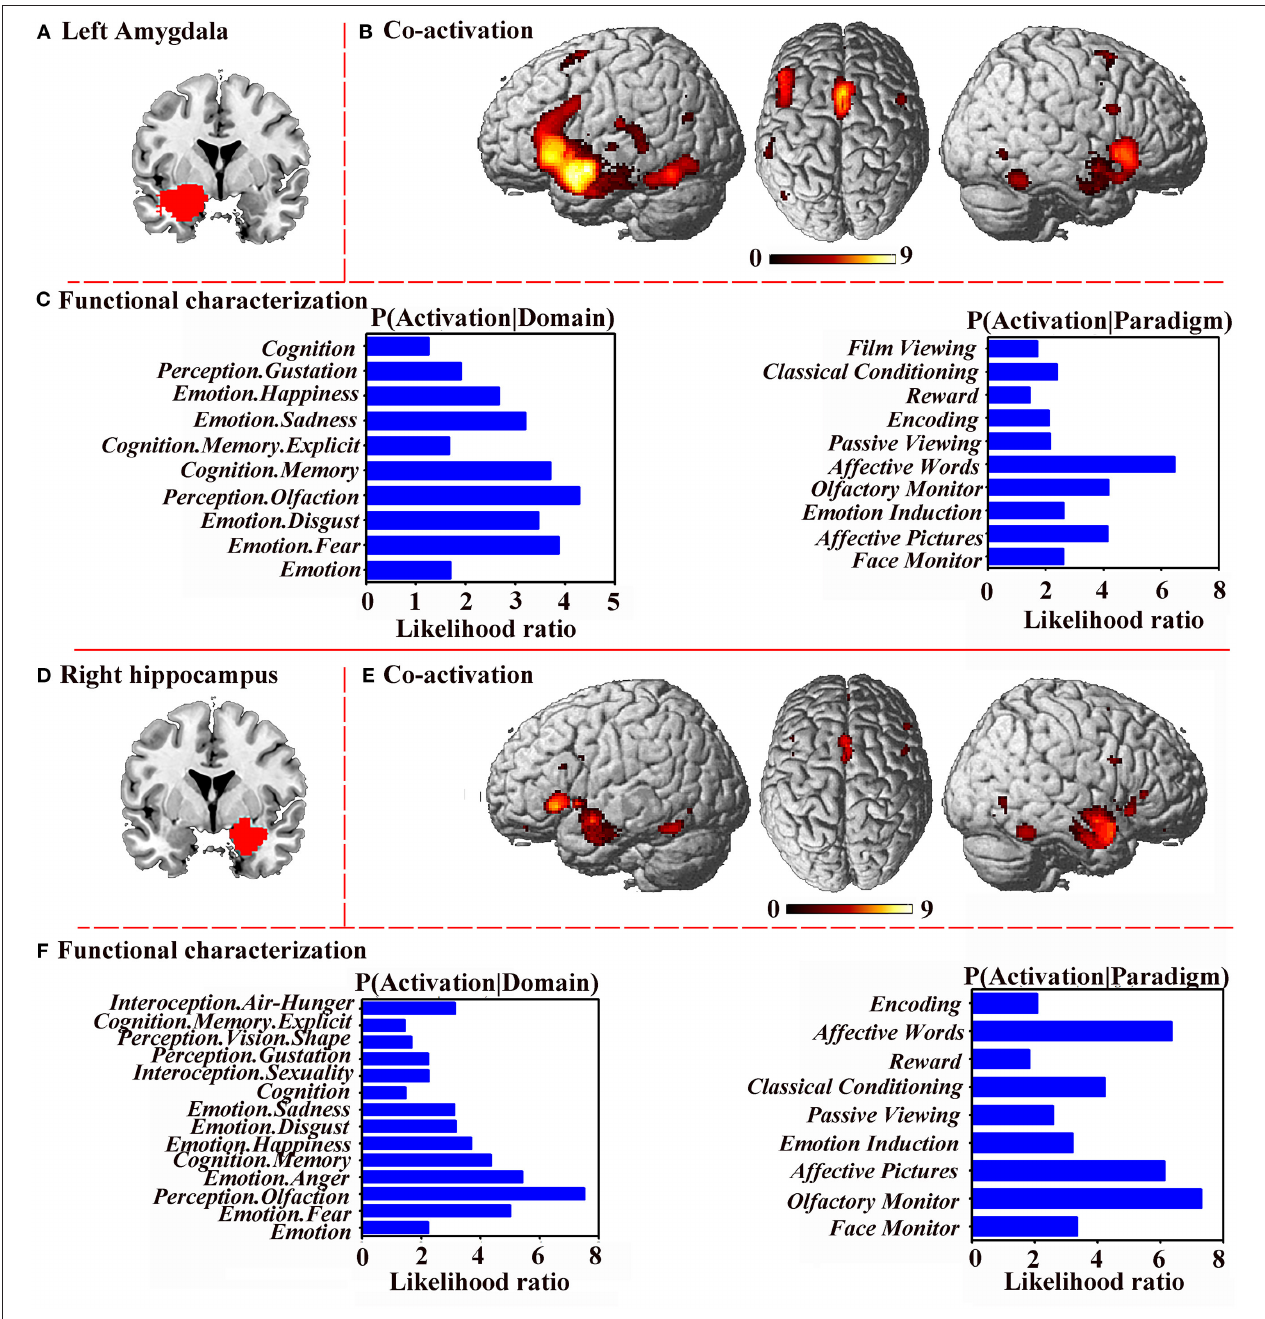
FIGURE 5 | Functional connectivity and characterization. (A) Left amygdala. (B) Co-activation connectivity analysis for left amygdala. (C) Functional characterization of left amygdala. (D) Right hippocampus. (E) Co-activation connectivity analysis for right hippocampus. (F) Functional characterization of right hippocampus. Functional characterization of significance levels was thresholded at p < 0.05, cluster-level FWE-corrected, cluster-forming threshold at voxel-level p < 0.001. Co-activation connectivity of significance levels was thresholded at p < 0.05, corrected for multiple comparisons using